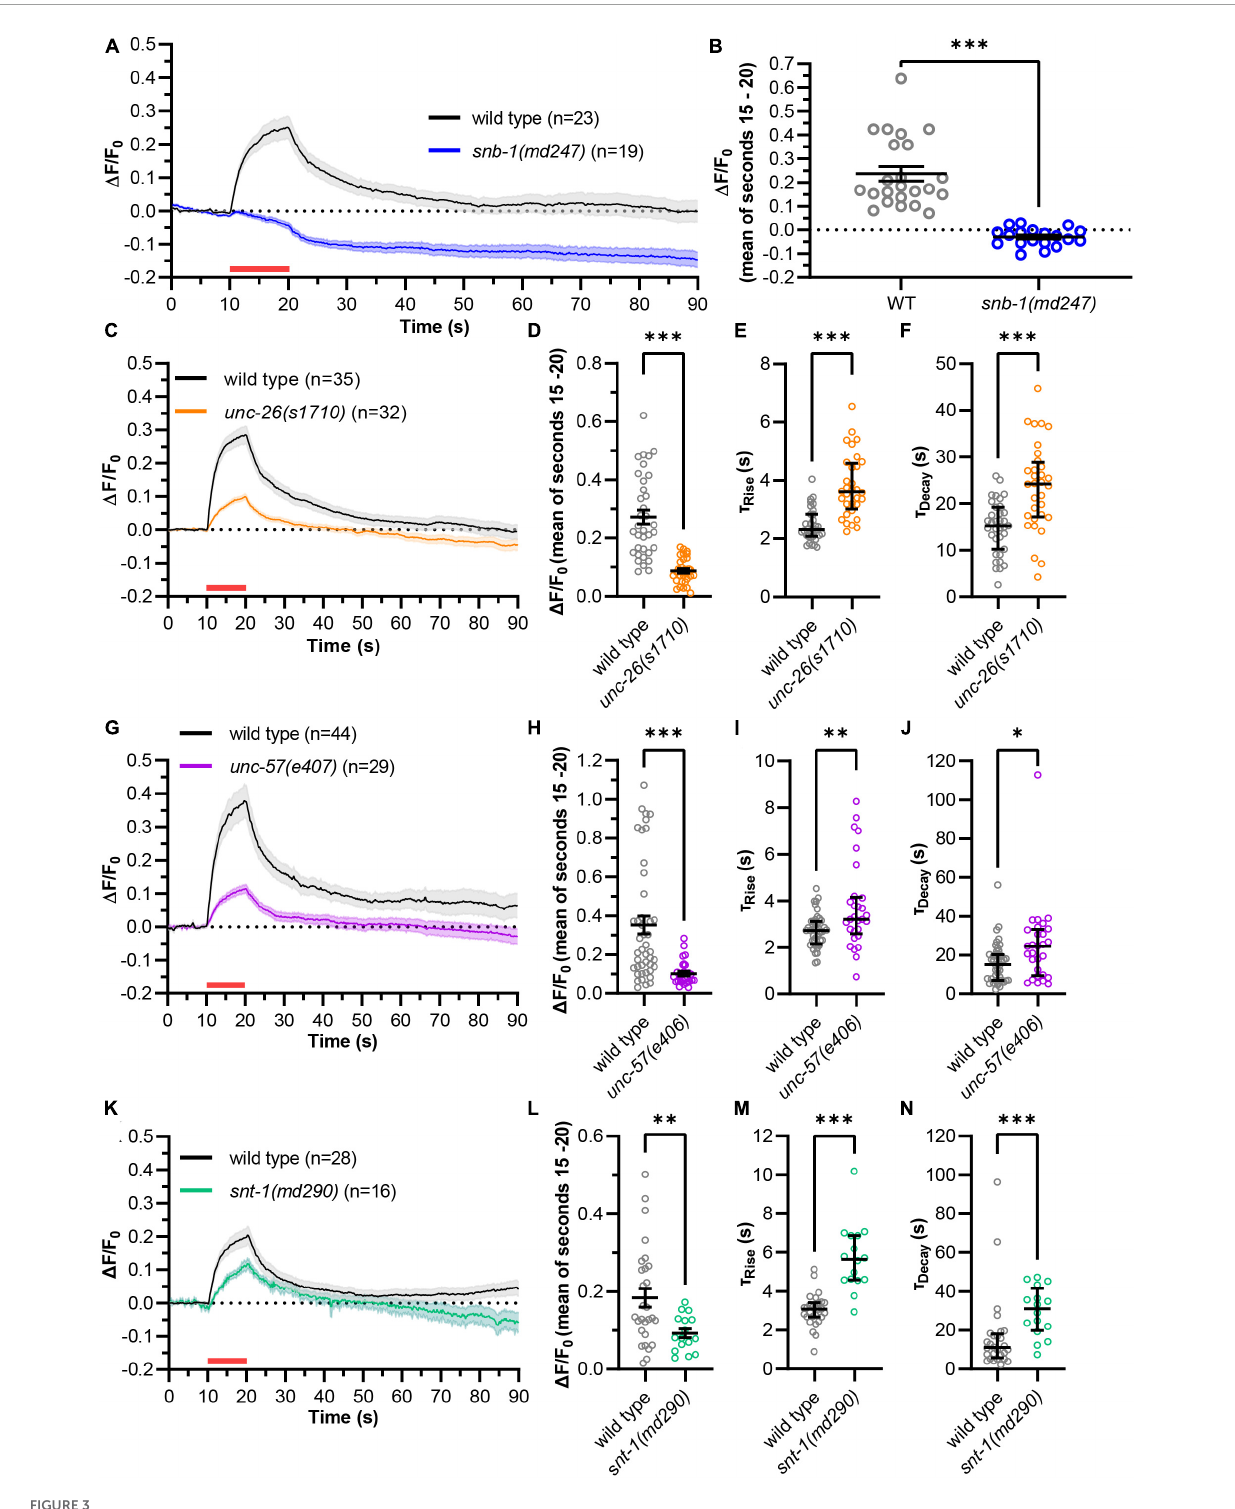
FIGURE3 “Green” pOpsicle reports on mutations affecting SV fusion and endocytosis. (A,C,G,K) Mean ( ± SEM) change of fluorescence of SNG-1::pHluorin co-expressed with ChrimsonSA in cholinergic motor neurons. DNC of wild type and mutant animals, as indicated. A 10 s continuous light pulse (590 nm, 40 µ W/mm 2 ; indicated by a red bar) was applied after 10 s. Number of animals ( n ), accumulated from N = 4–6 biological replicates. (B,D,H,L) Fluorescent signal of individual wild type and mutant animals at the end of stimulation (15–20 s). Mean ( ± SEM). Unpaired t -test ( ∗∗ p < 0.01, ∗∗∗ p < 0.001). (E,I,M) Calculated fluorescence rise constants of single animals using a one-phase exponential fit during stimulation (10–20 s). Median with interquartile range. Mann–Whitney test ( ∗∗ p < 0.01, ∗∗∗ p < 0.001). (F,J,N) Calculated fluorescence decay constants of single animals using a one-phase exponential fit after stimulation (20–90 s). Median with interquartile range. Mann–Whitney test ( ∗ p < 0.05, ∗∗∗ p < 0.001). In panels (C–N) , animals showing an increase < 3 standard deviations during stimulation, or no decay of fluorescence following stimulation, were excluded [wild type: 4 of 111 animals, unc-26(s1710) : 7 of 39, unc-57(e406) : 18 of 47, snt-1(md290) : 23 of